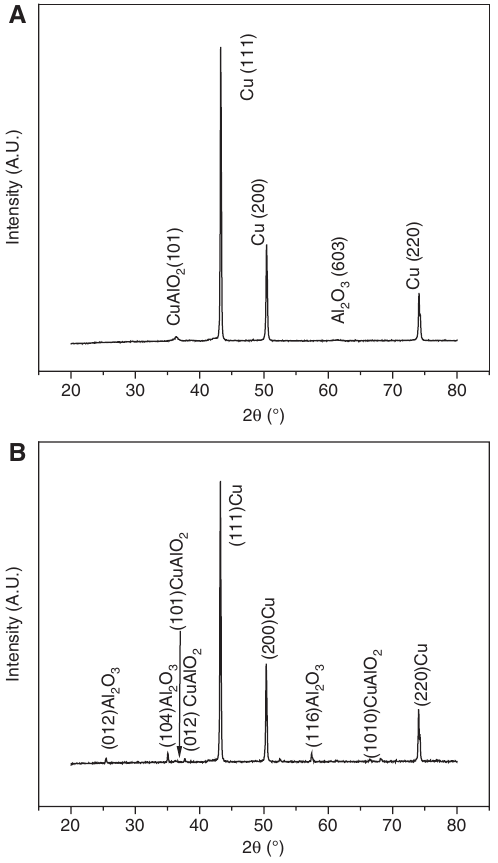
Figure 1: XRD diffraction patterns of (A) Cu-7 vol.% Al posites and (B) Cu-20 vol.% Al